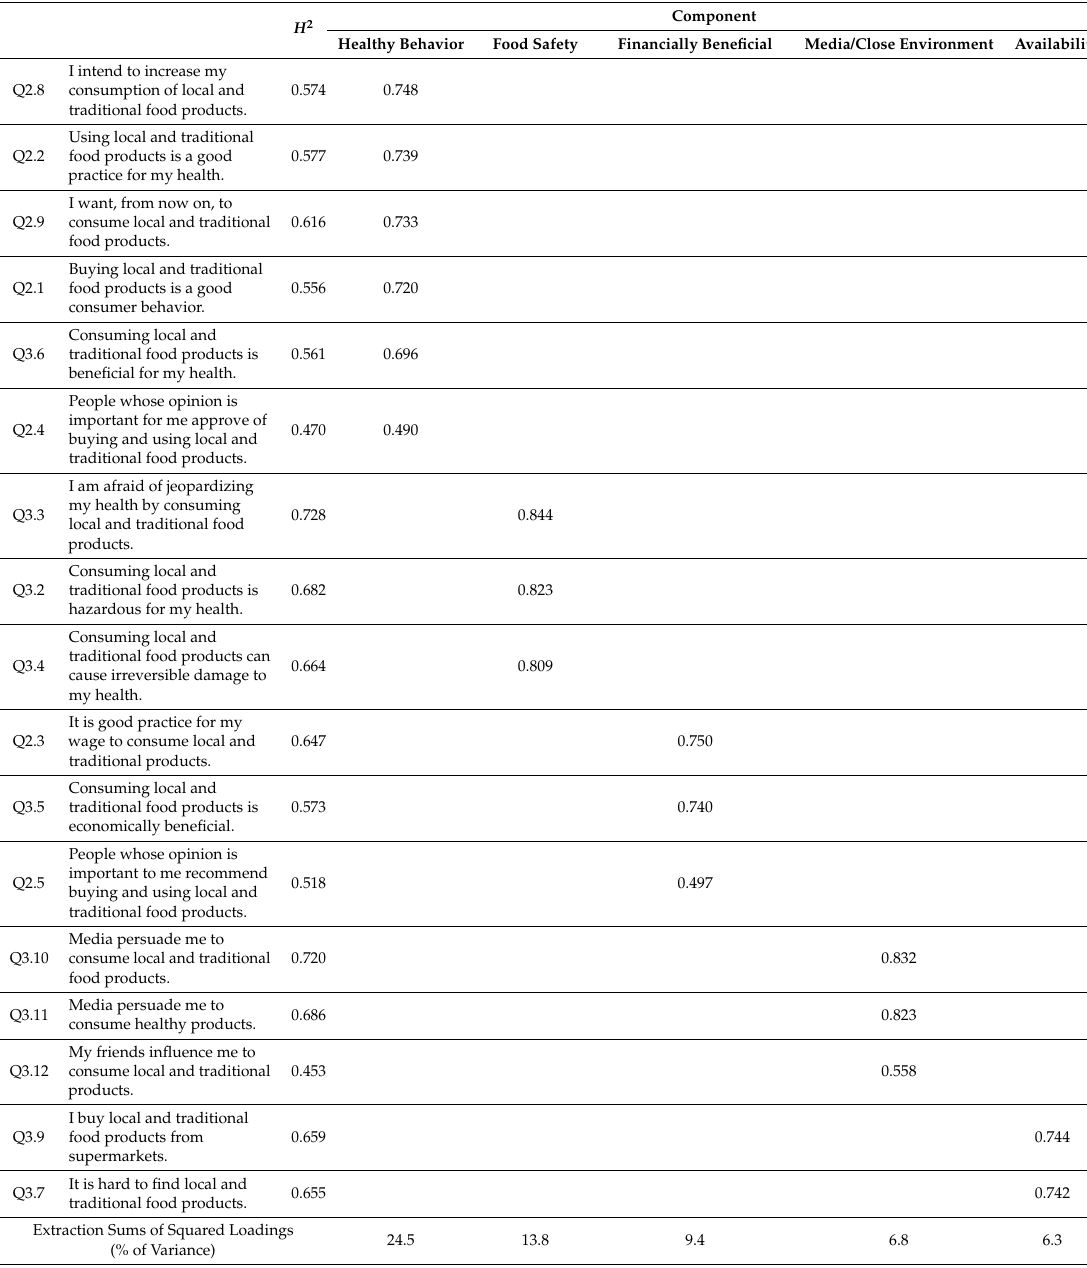
Table 4. Principal Component Analysis (PCA) results for the overall sample ( n =